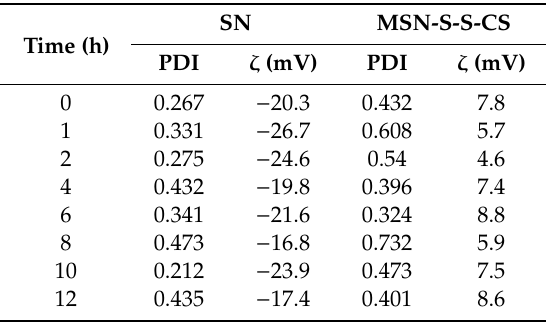
Table 3. Changes in particle size and potential of MSN and MSN-S-S-CS in C 2 H 5 OH.